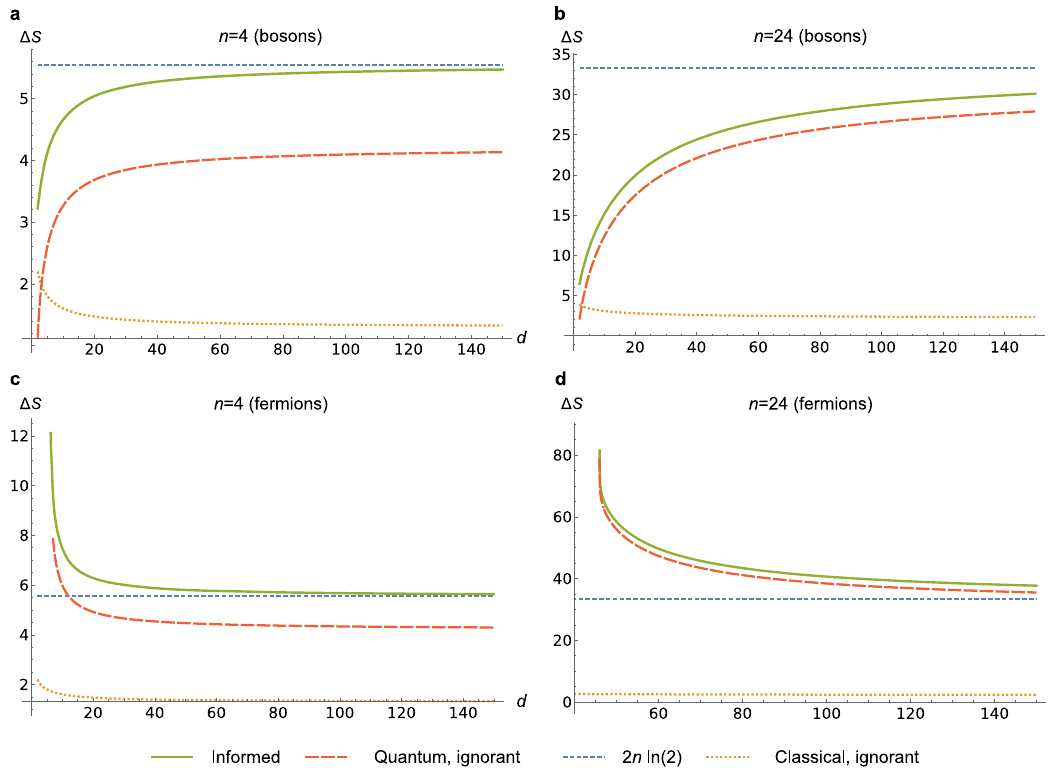
Fig. 3 Entropy changes as a function of dimension. Series of plots showing Δ S info , Δ S igno against the total cell number d of the system. a , b Bosonic systems of particle number n = 4 and n = 24 respectively. c , d The same for fermionic systems. Note that we have taken the initial number of particles on either side of the box to be equal, n = m in all cases. For comparison, all four fi gures also display the classical changes in entropy for an informed/ignorant observer. The behaviour of the de fi cit between Δ S for an informed/ignorant observer of quantum particles agrees with the low density limit in Eq. (23) where we can see Δ S info tending to the classical limit 2 n ln ð 2 Þ with Δ S igno trailing behind by a de fi cit of n 2 /2 d 2 + H ( p ). Additionally, by comparing the different plots, we can see the low-dimensional fermionic advantage where the change in entropy is even greater than the classical 2 n ln ð 2 Þ